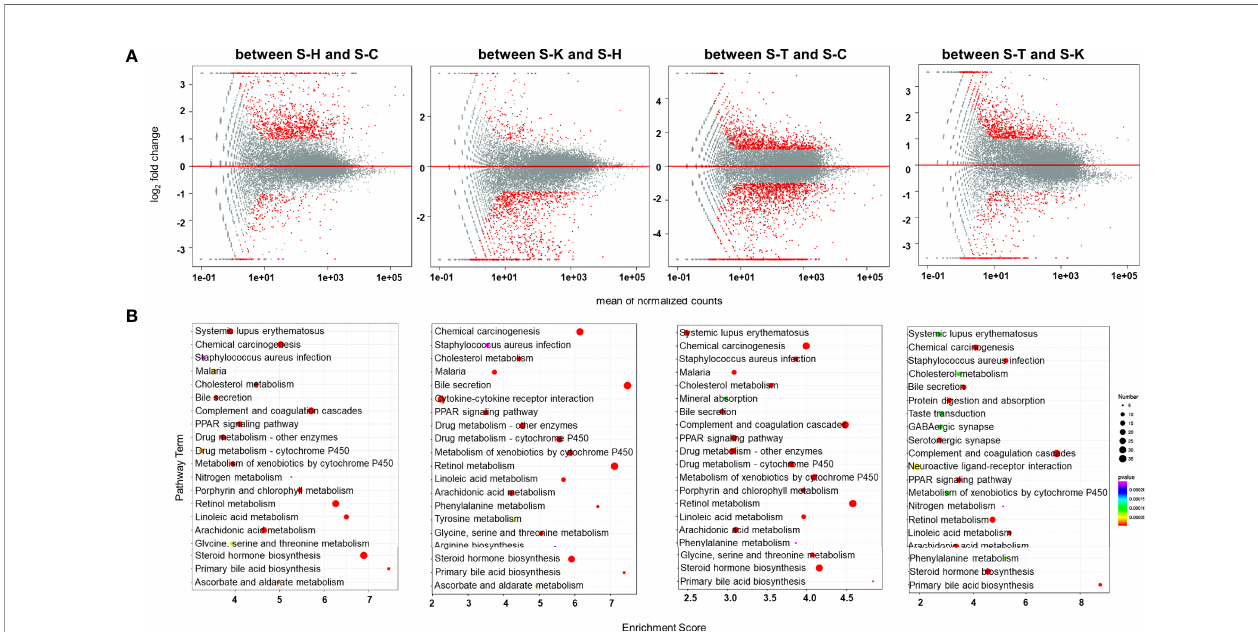
FIGURE 9 | Transcriptomic analysis of the spleens of rats. (A) MA (M-versus-A) plots of differential expressing genes in spleens between the four rat groups including healthy controls (S-H) (n=6), CIA rats (S-C) (n=6), CIA rats treated with 2-DG (S-T) (n=6), and healthy rats treated with 2-DG (S-K) (n=6). (B) Bubble charts showing the top 20 differentially enriched pathways in the rat spleen among the four rat